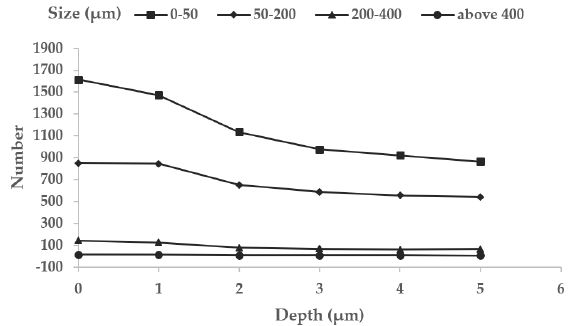
Figure 2. Evolution of the number and size of damages with repair depth.